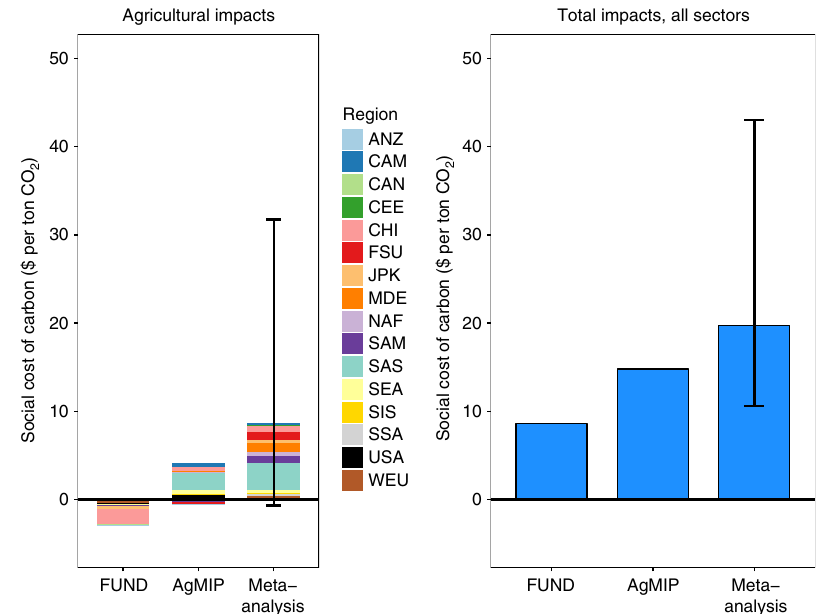
Fig. 4 Changes in the social cost of carbon resulting from new damage functions in the agricultural sector. a Agricultural impacts only, decomposed by geographic region (see Supplementary Table 4 for region de fi nitions). b The total social cost of carbon (SCC), keeping damages in all non-agricultural sectors fi xed. Results are based on a business-as-usual emissions scenario and a 3% discount rate. Uncertainty bars give the SCC resulting from the 95% con fi dence interval of yield response parameter estimates from the